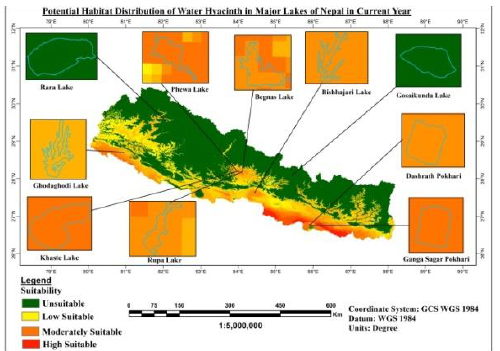
Figure 3. Potential Habitat Distribution of Water Hyacinth in the Lakes in current